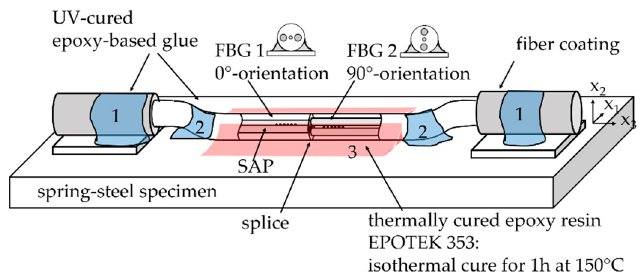
Figure 5. Sensor design with a surface-attached PM tandem: The fiber was azimuthally aligned with the slow axis of FBG1 and the fast axis of FBG2 parallel to the specimen’s surface and pre-fixed on the specimen with UV-cured epoxy resin at two points next to the FBGs (marked in blue). Afterwards, the entire sensing element was glued over a length of about 4 cm with thermal cured epoxy resin.